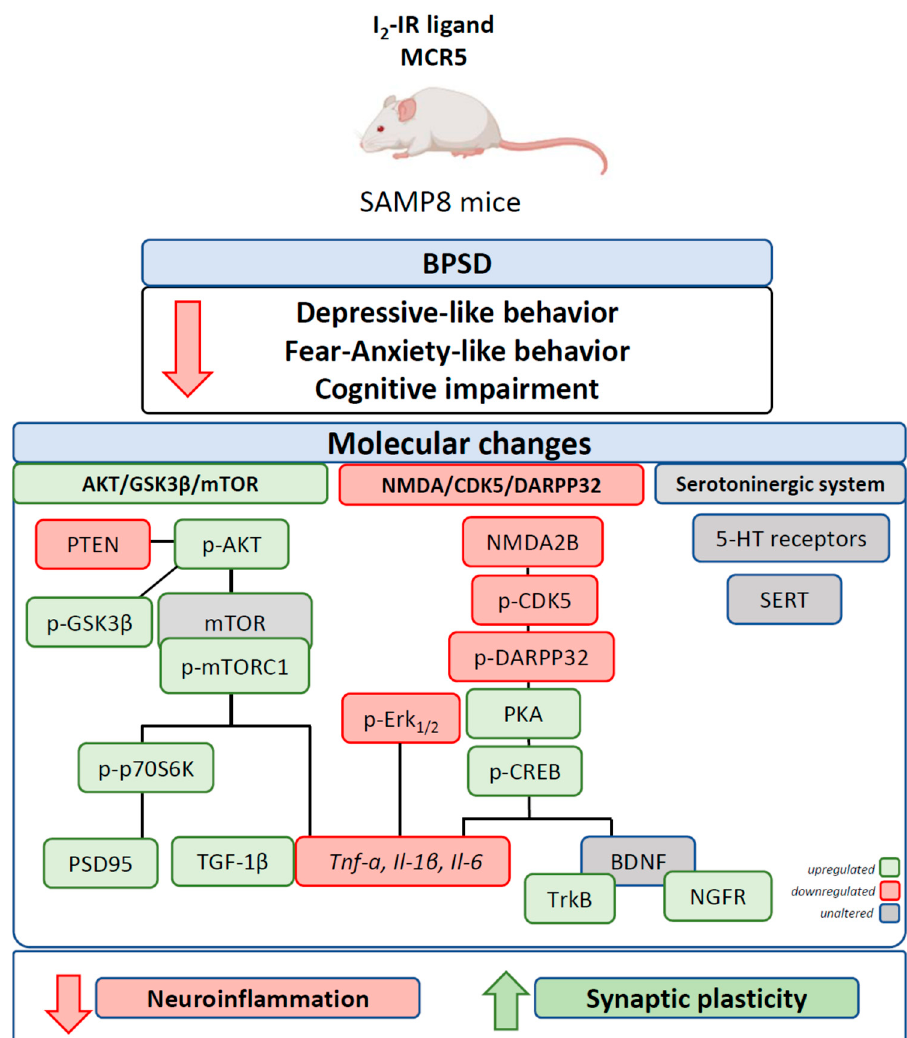
Figure 8. Cartoon illustrating a summary of behavioural, cognitive and molecular effects after MCR5 treatment in SAMP8 mice. Table S1: Antibodies used in Western blot studies, Table S2: Primers and probes used in qPCR studies, Table S3: Results of Novel object recognition test (NORT), and Object location test (OLT) Table S5: Parameters measured in the Open Field Test (OFT), Table S6: In Vitro Pharmacology: Binding Assays for MCR5 (10 µ M) to 5-HT receptors and